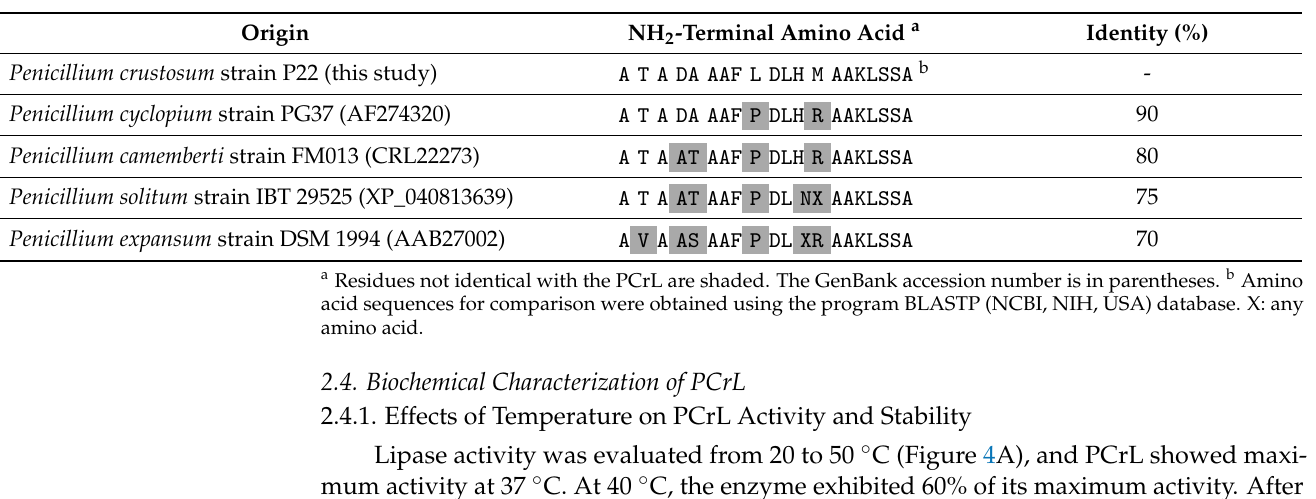
Table 2. Alignment of the NH 2 -terminal amino-acid sequence of PCrL with that of other Penicillium lipases.